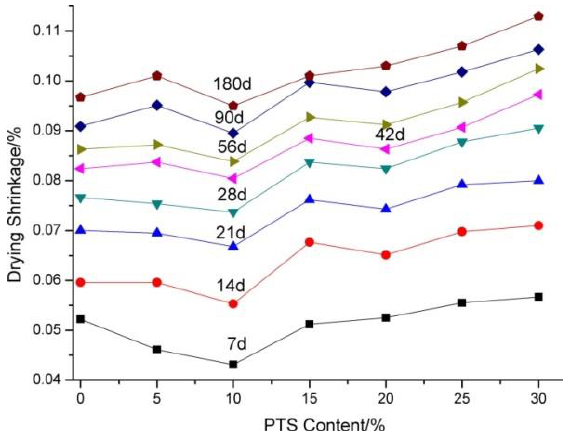
Figure 15: Effect of tailings on drying shrinkage [32]